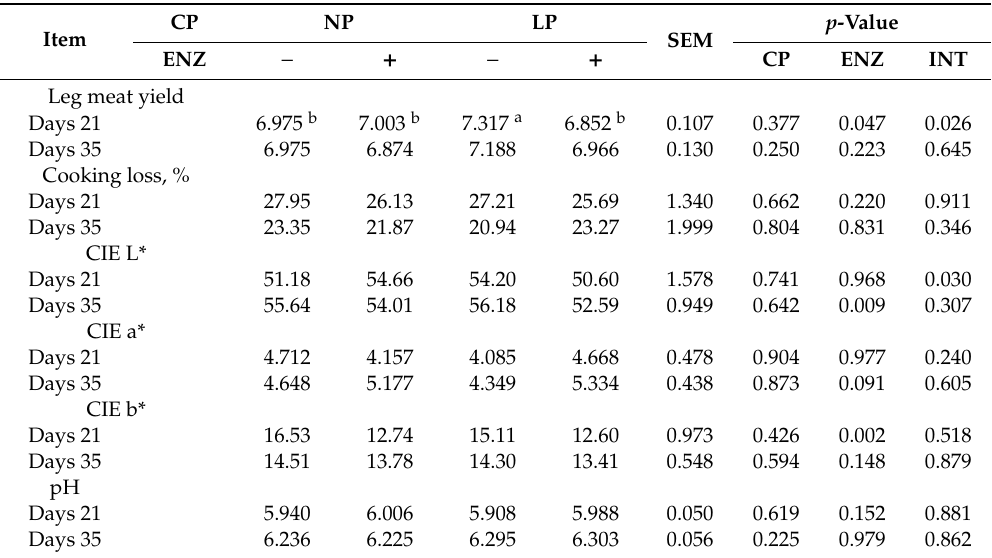
a,b Values ( n = 12 / treatment) having a di ff erent superscript with a row di ff er significantly ( p < 0.05). CP = crude protein diet; NP = normal protein diet, LP = low-protein diet; ENZ = protease; INT = interaction; DM = dry matter;